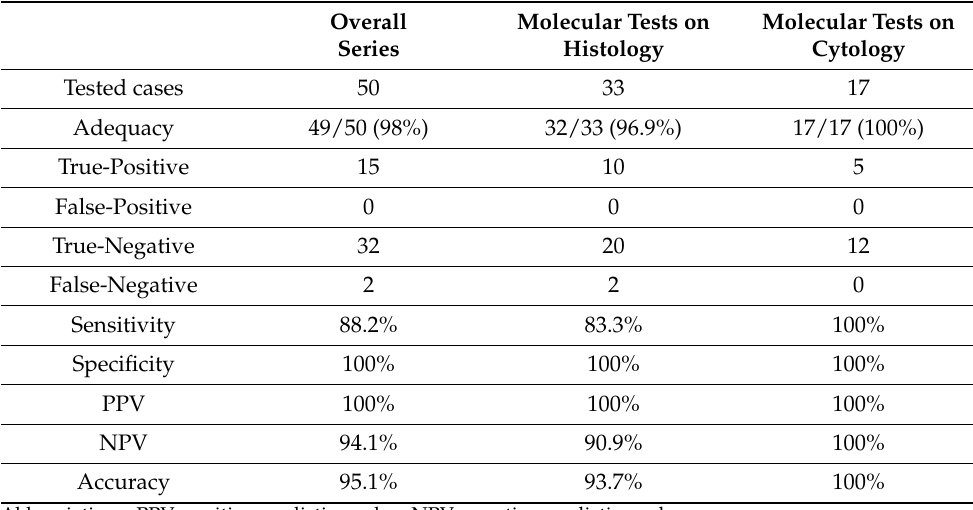
Table 2. Diagnostic performance of BRAF V600E mutation-specific